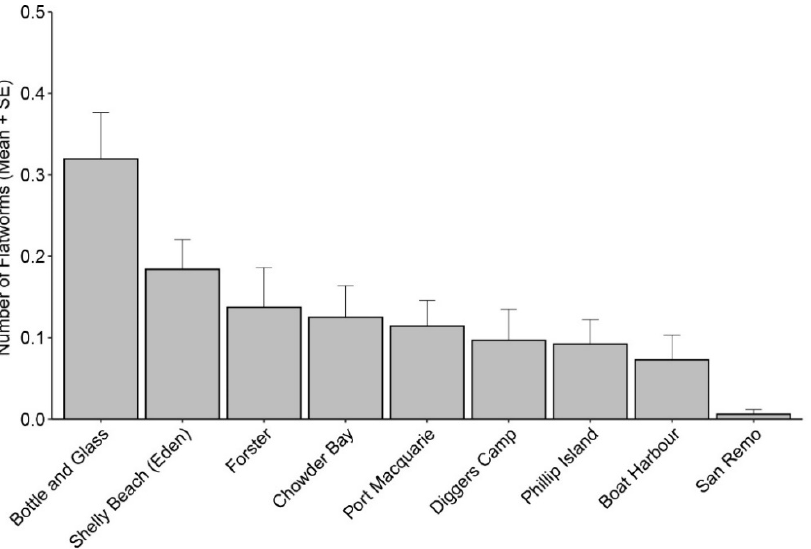
Figure 3. Differences in the average (+SE) abundance of flatworms found at each site sampled along the southeastern coast of Australia.